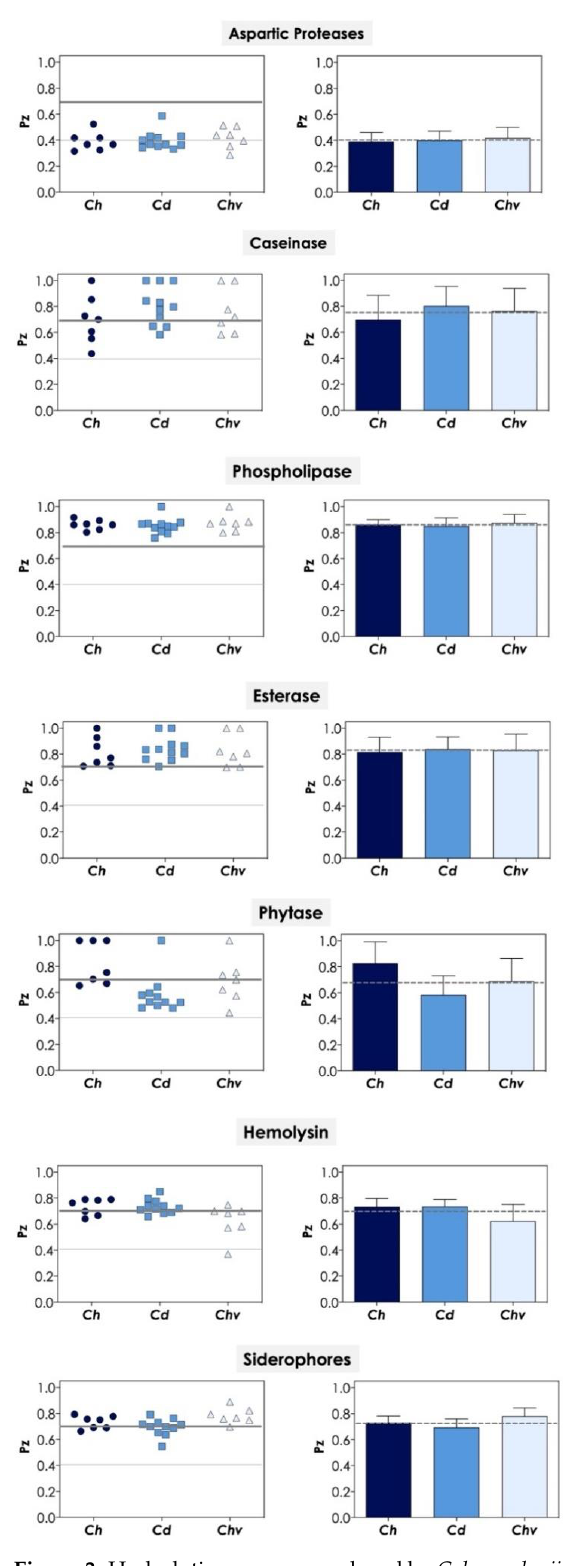
Figure 3. Hydrolytic enzymes produced by C. haemulonii species complex. The distribution of aspartic protease, caseinase, phospholipase, esterase, phytase, hemolysin and siderophores production